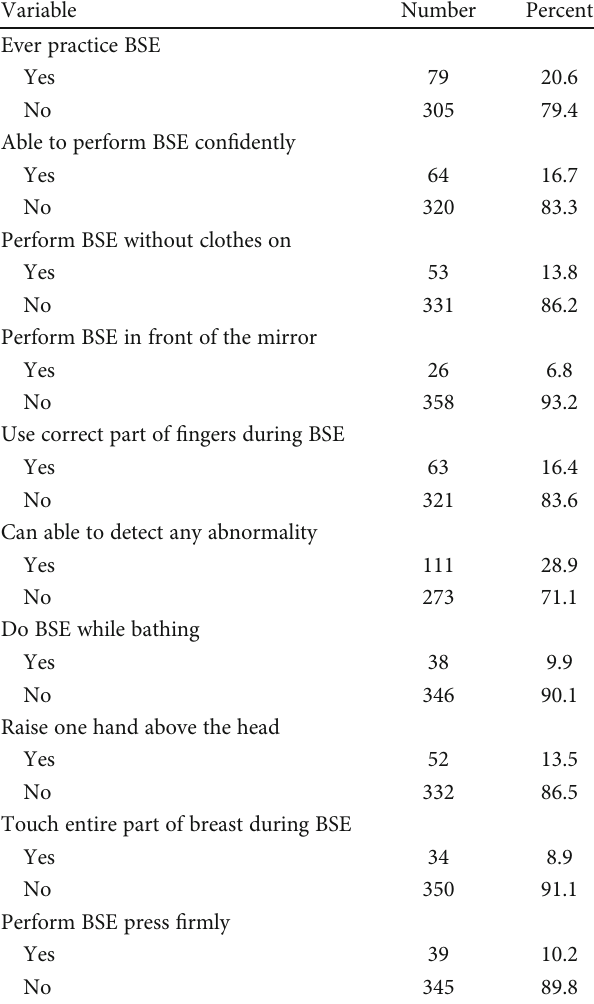
Table 3: Practice of breast self-examination among summer social science female students in University of Gondar, Northwest Ethiopia, 2018 ( n = 384